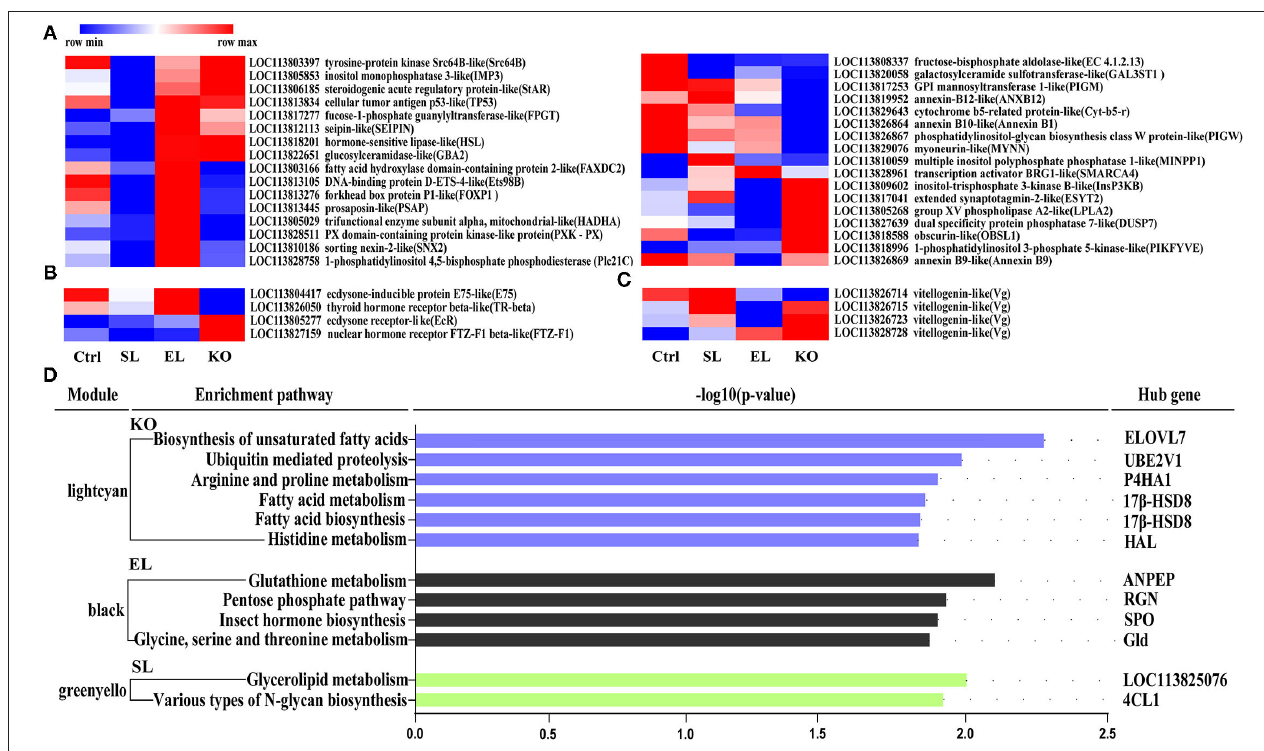
FIGURE 10 | Gene expression (FPKM) clustering heatmap of lipid-related genes (A) , hormone-related genes (B) and reproduction-related genes (C) . Each column in the figure represents a group, and each row represents a gene. Colors from dark blue to dark red indicate the contents of lipid molecules from min to max within a row. (D) Pathway enrichment analysis plots of the hub genes with the strongest connectivity in the module. Enrichment differences are expressed in terms of –log10 (p-value). The Lightcyan module is derived from the krill oil group, the black module is derived from the EL group, and the green-yellow module is derived from the SL group. The pathway on the left is the core gene enrichment pathway on the right. Ctrl (control, phospholipid-devoid), SL (added 4% soybean lecithin), EL (added 4% egg yolk lecithin), and KO (added 4% krill